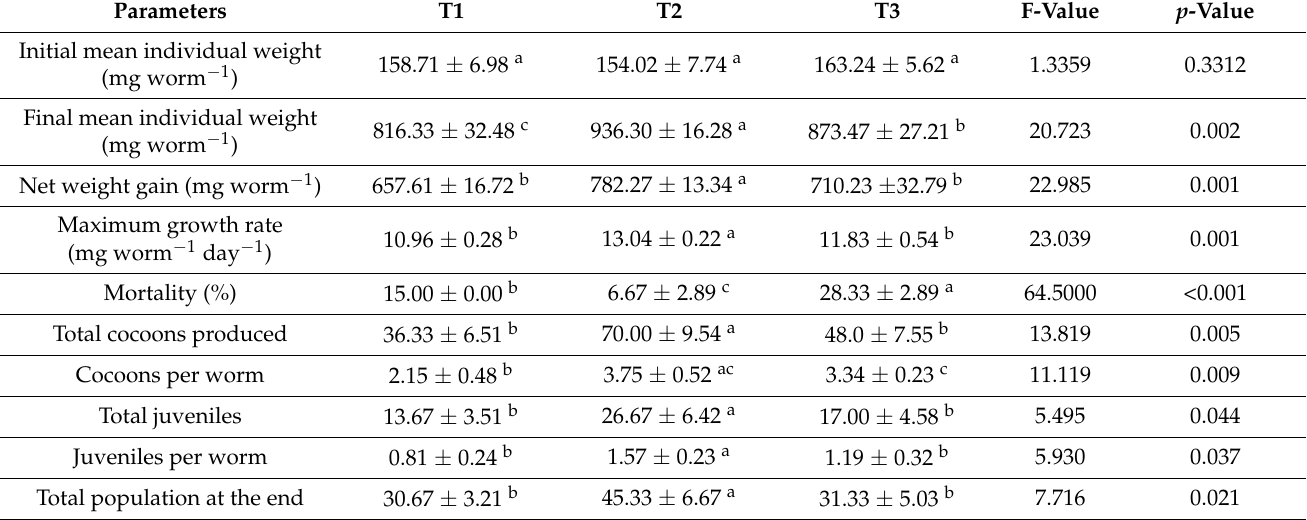
Table 3. Biomass, fecundity, and mortality of Eisenia fetida in different treatments. Data are the mean ± SD of three replicates ( n =